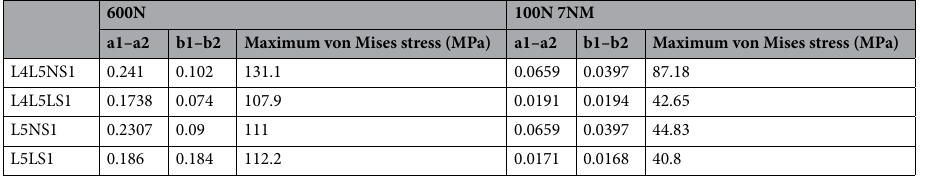
Table 7. Experimental results in each simulation state.